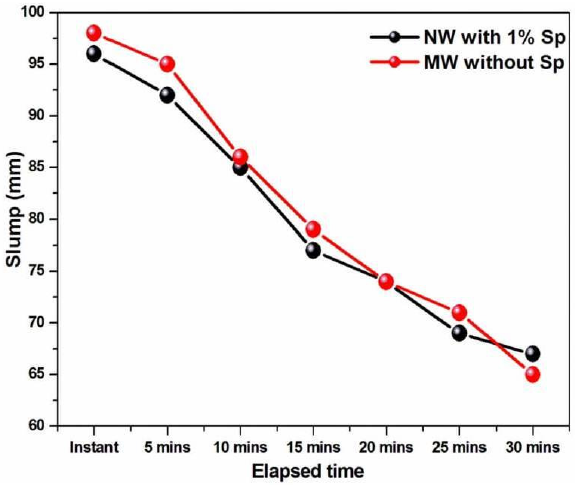
Figure 7. Slump loss of concrete (NW with 1% optimized SP and MW with 0% SP).